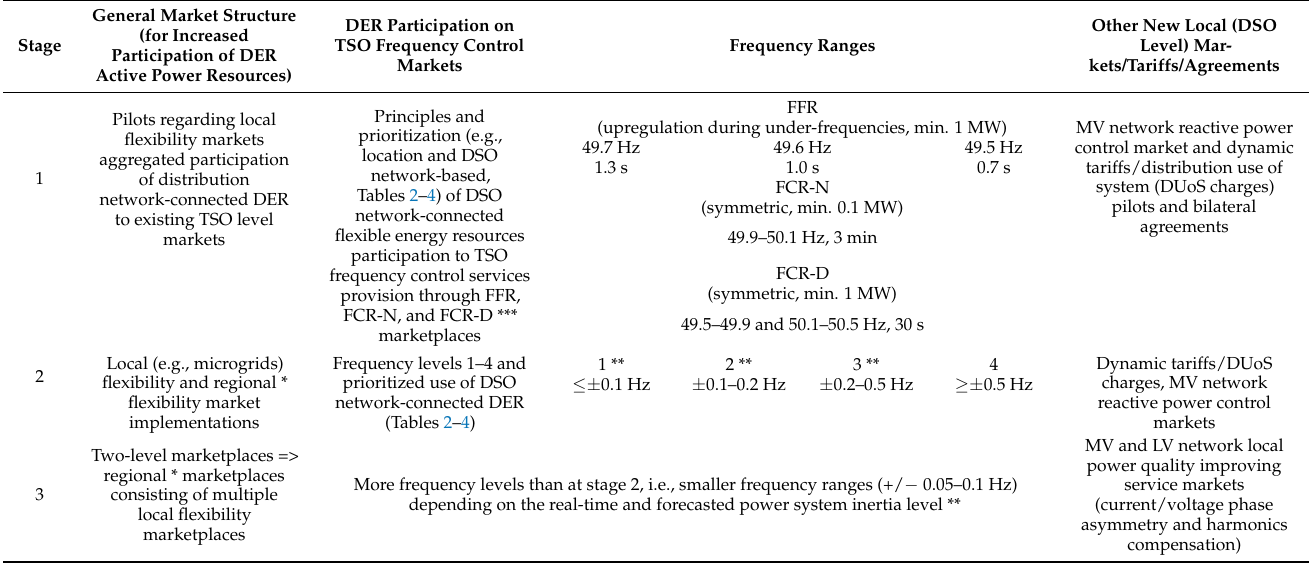
Table 6. Collaborative (TSO-DSO) and adaptive control and management methods compatible (Tables 2–5) market schemes evolution during different stages 1–3 with special focus on frequency control markets (see Figures 3 and